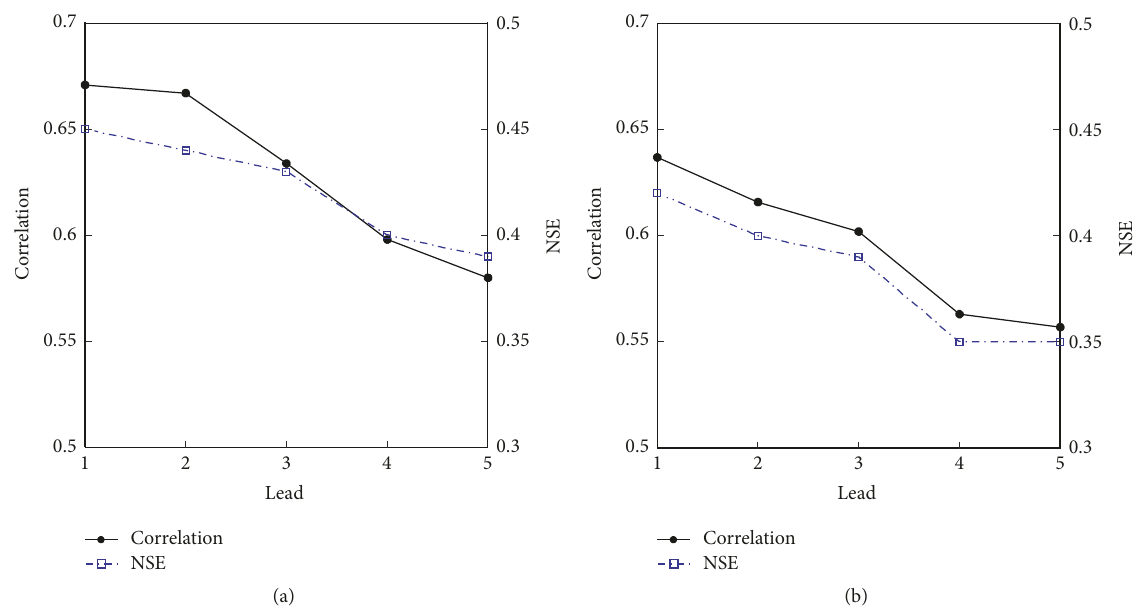
Figure 3: The correlation and NSE for 1–5 months’ lead time for the IMME at the northern (a) and central (b) parts of the domain.